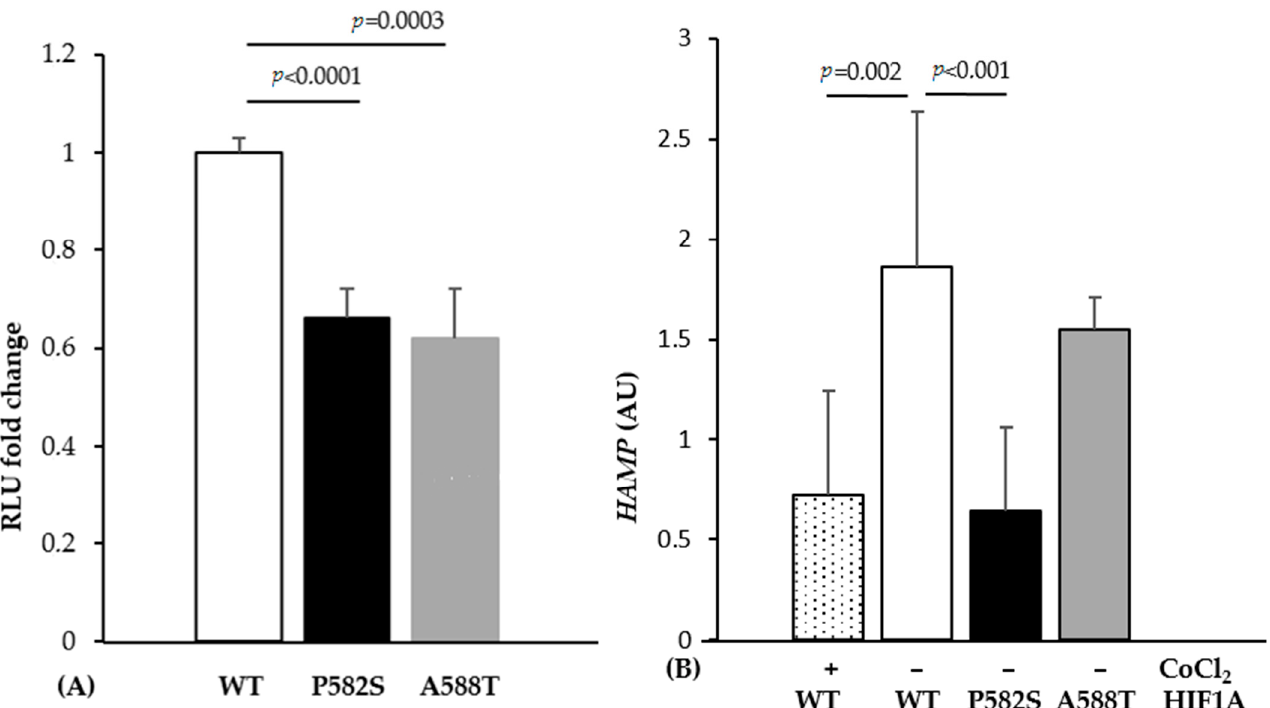
Figure 1. ( A ) Luciferase activity expressed as a fold change in the wild type (WT) and mutant vectors (P582S and A588T), as reported. ( B ) The HAMP mRNA levels expressed as the ratio between transfected and non-transfected Huh-7 cells under normoxic ( − ) and hypoxic (+) conditions. All data were obtained from three independent experiments done in triplicate.